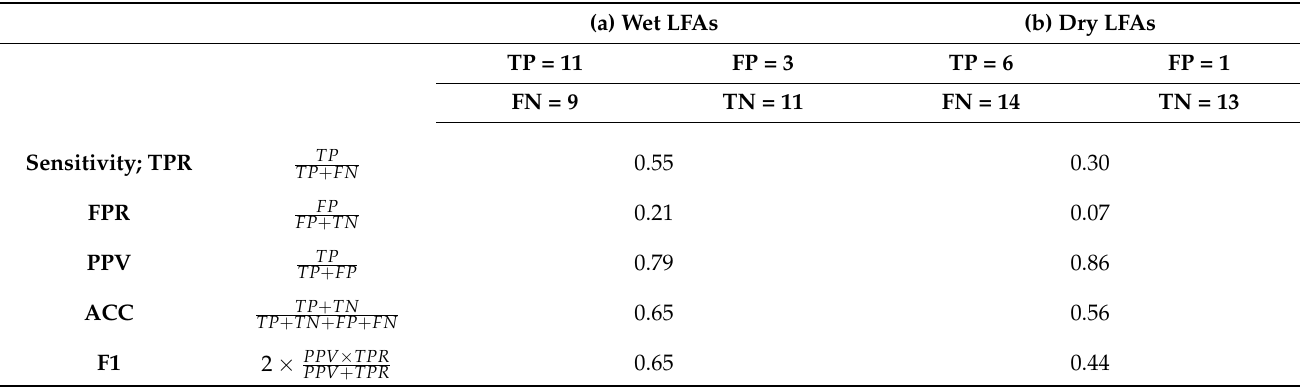
Table 3. Statistical analysis of thermal contrast amplification (TCA) testing on wet versus dry lateral flow assays (LFAs) for influenza A detection: (a) wet LFAs; (b) dry